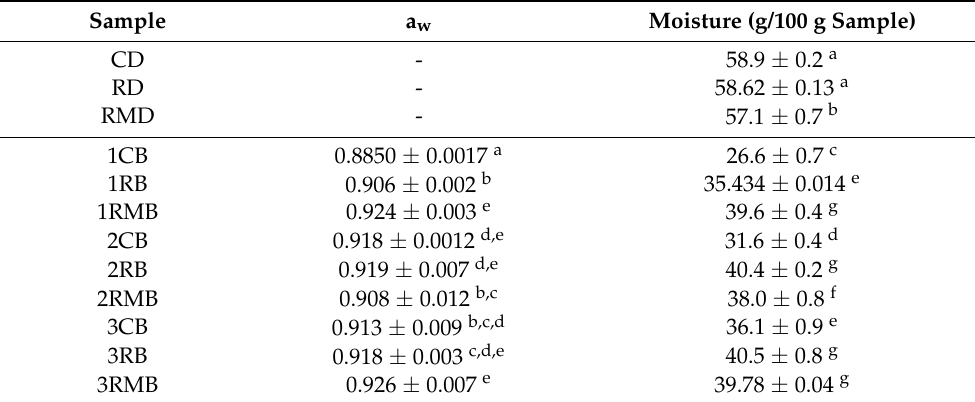
Table 2. Physico-chemical parameters of doughs and breads (C, control; R, rosehip; RM, encapsulated rosehip; 1, 2, 3 cm height; D, dough; B, bread).